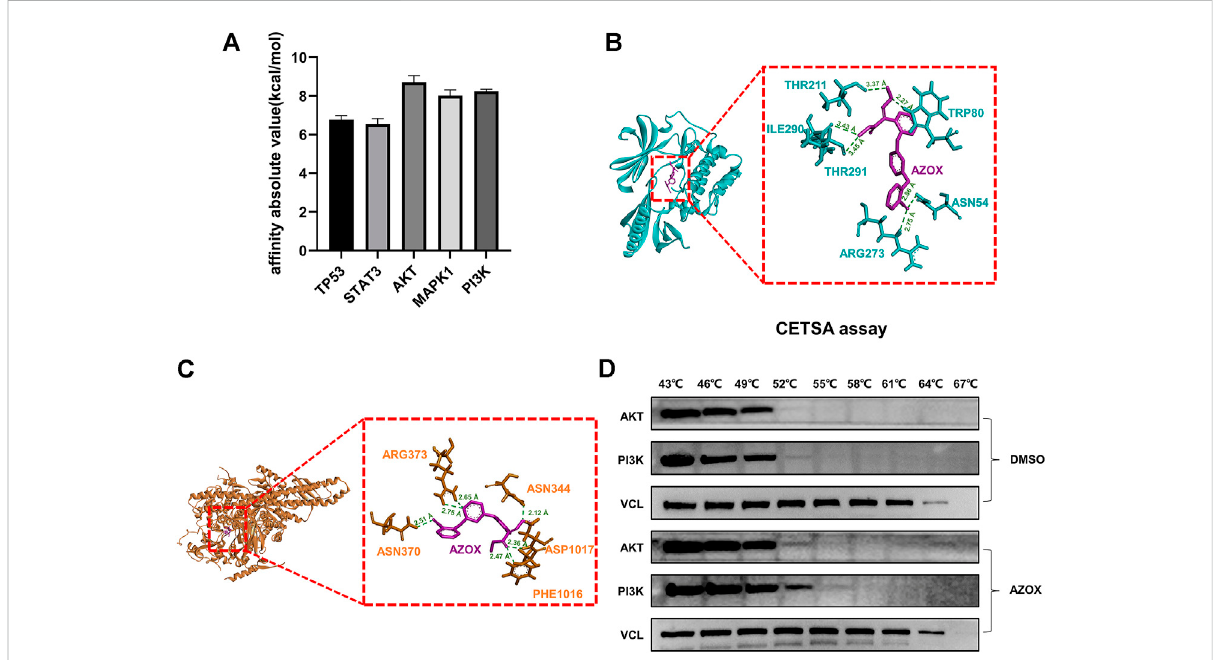
FIGURE 7 Comparisonofhubtargetsbymoleculardockingandveri fi cation. (A) Bargraphofhubproteinmeanscorevaluesofthetoptendockingscores. (B) 3DdockingconformationofAZOXwithAKT.GreendashedlinesrepresentH-bondsandthenumbersdenotethedistanceoftheH-bonds. (C) 3D docking conformation of AZOX with PI3K. Green dashed lines represent H-bonds and the numbers denote the distance of the H-bonds. (D) CETSA and Western blot analysis showed that AZOX may directly bind to AKT and